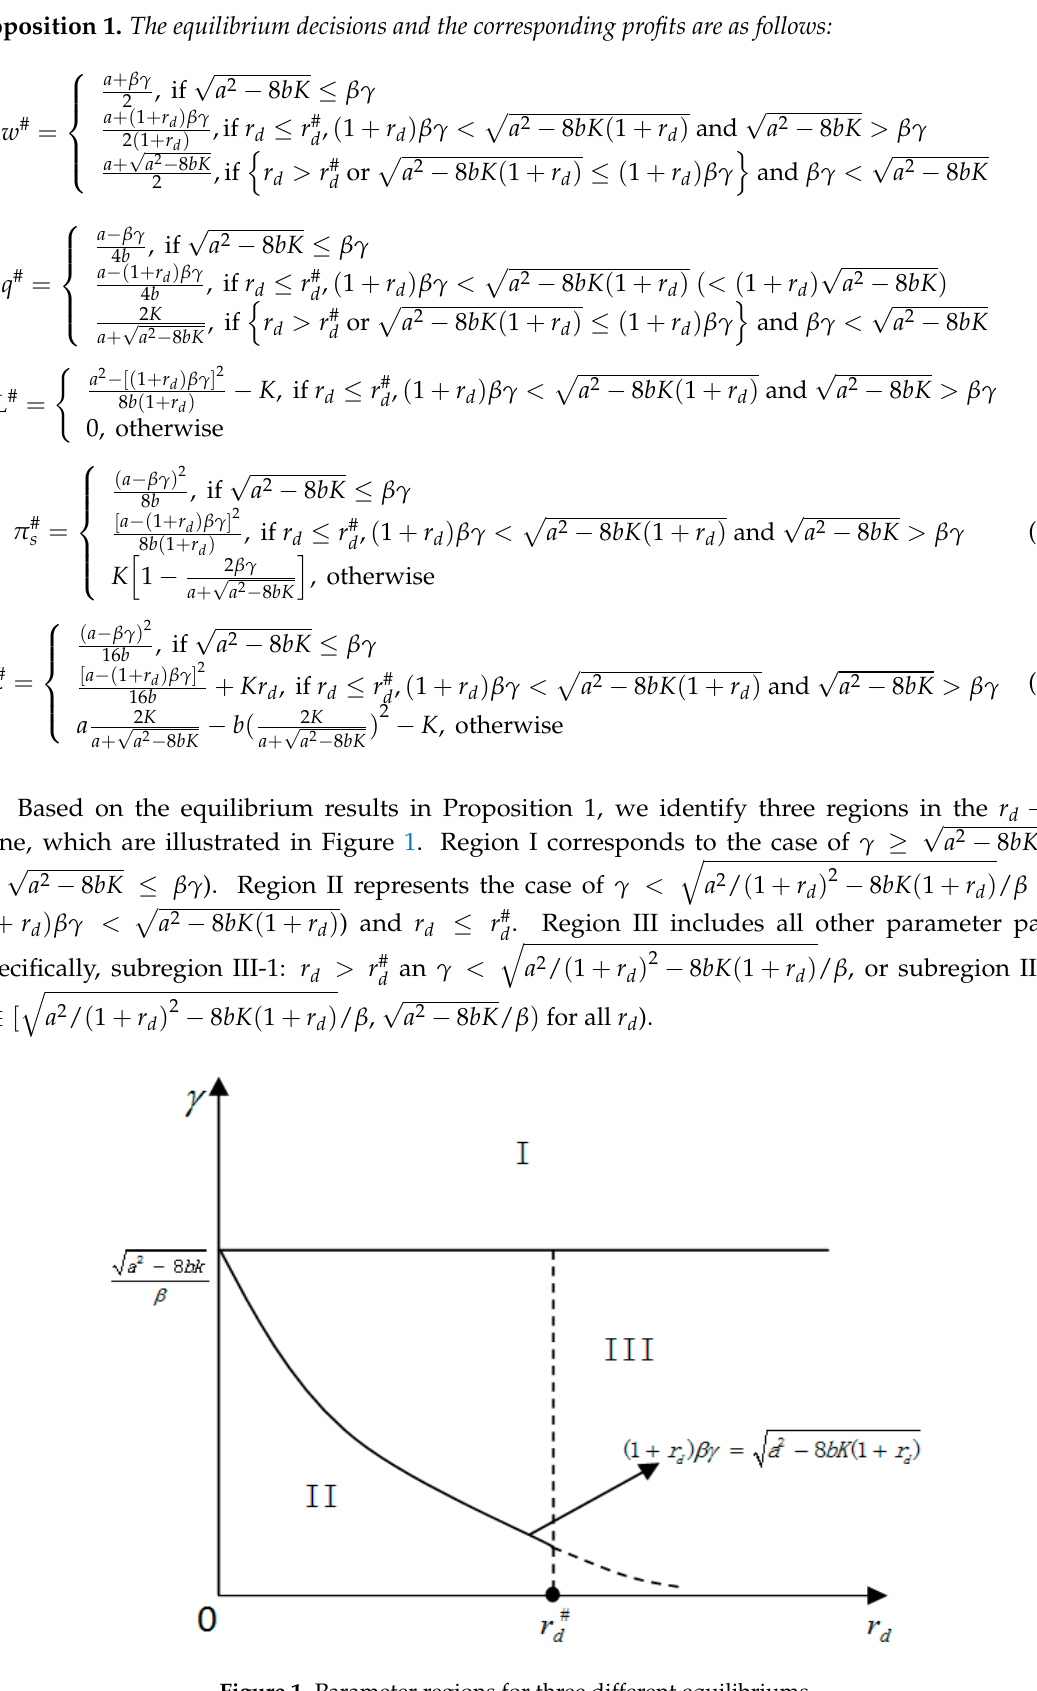
Figure 1. Parameter regions for three different equilibriums.